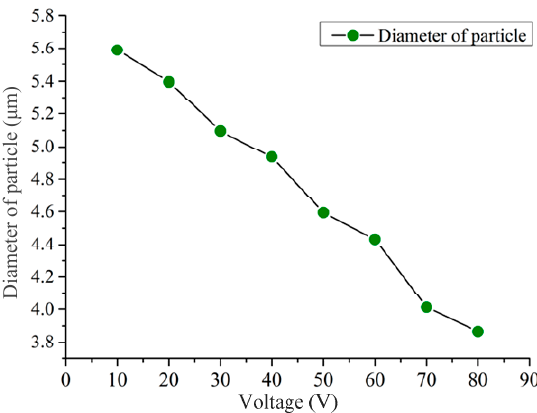
Figure 14. Variation in the diameter of the atomized particles with working voltage.